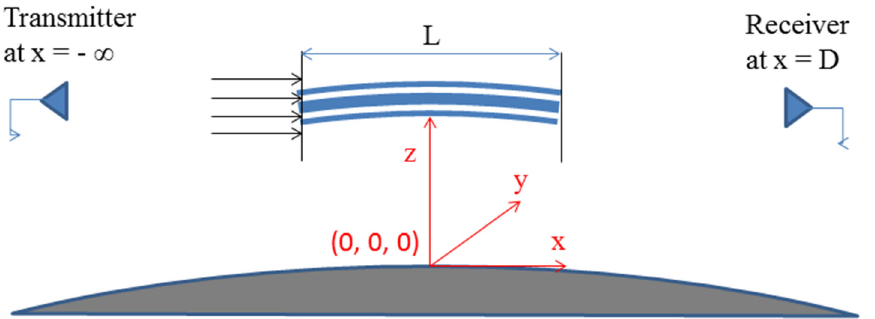
Figure 1. Geometry of an Es layer scintillation problem on GPS/GNSS RO observations. The origin is allocated as the point at which the Es layer’s center is projected onto the Earth’s surface. The x and z axes point in the GPS-LEO limb’s viewing direction and the azimuth direction, respectively.